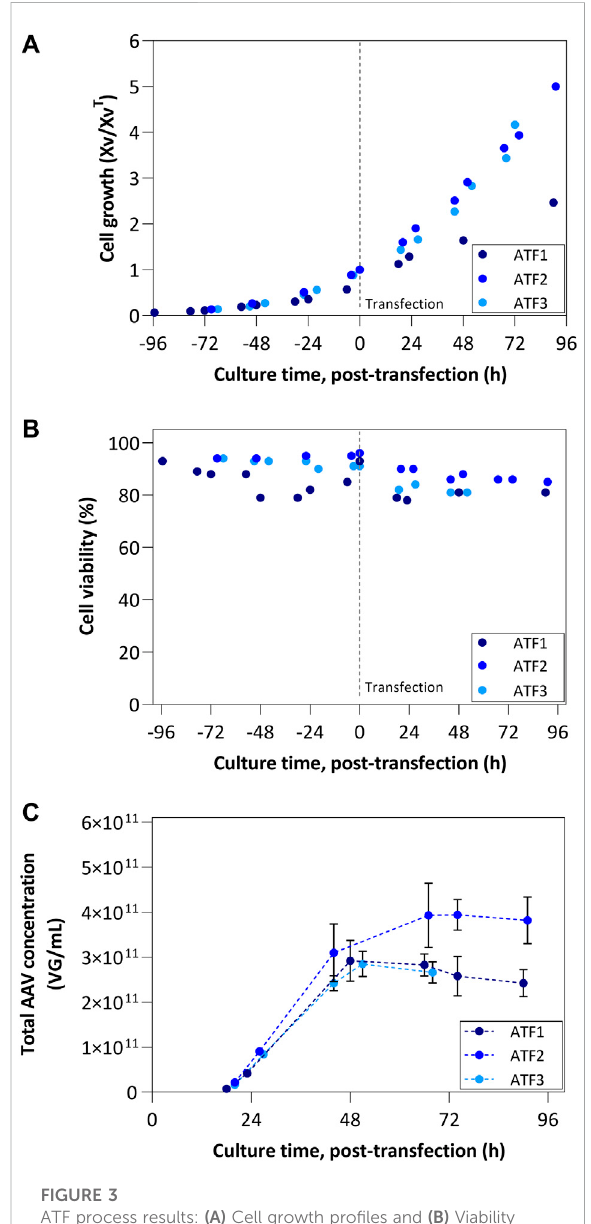
FIGURE 4 TFDF process results: (A) Cell growth pro fi les and (B) Cell viability pro fi les TFDF1 was transfected at 10 × 10 6 cells/mL, while remaining runs transfected at 5 × 10 6 cells/mL; Cell growth is represented by normalizing viable cell concentration by the VCC at the time of transfection; (C) Concentration of total AAV produced considering intracellular, extracellular and permeate